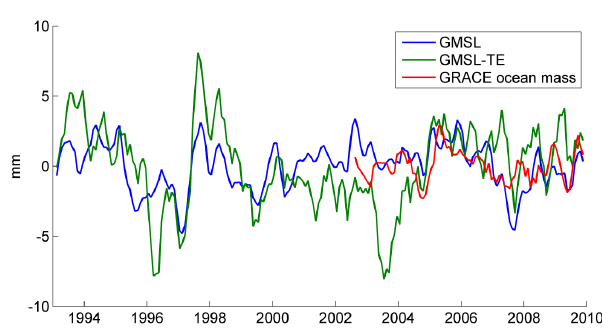
Fig. 4. Comparison of global mean sea level (GMSL) computed Figure 4: Comparison of global mean sea level (GMSL) computed from altimetry, GMSL 3 from altimetry, GMSL corrected from the thermal expansion TE corrected from the thermal expansion TE and GRACE ocean mass. 4 5 and GRACE ocean mass.